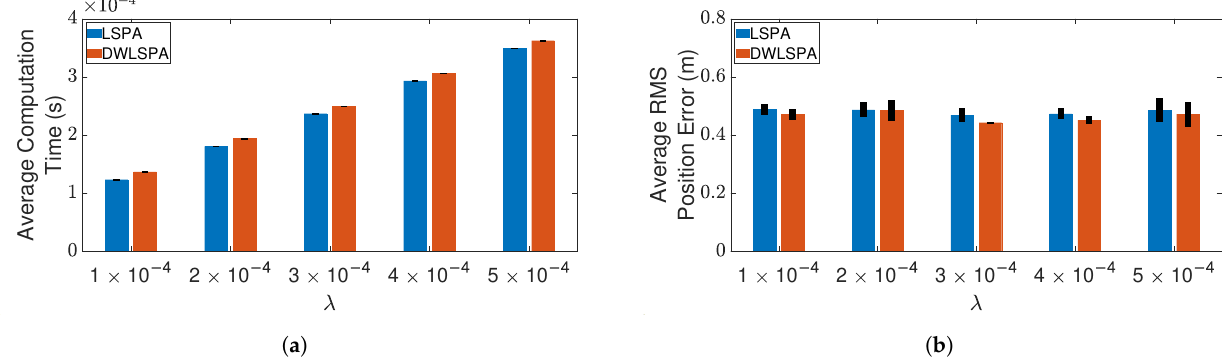
Figure 12. Tracking three crossing targets using LSPA and DWLSPA. ( a ) Average computation time for obtaining association probabilities; ( b ) average RMS position error. Error bars indicate 95% confidence